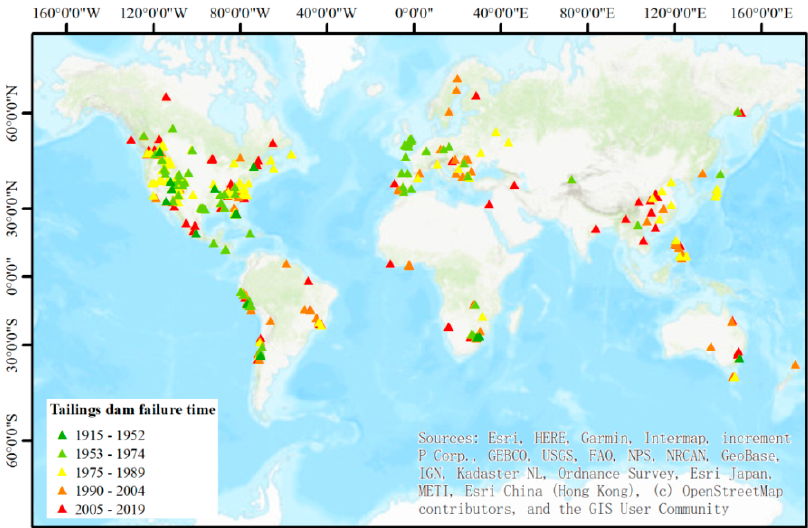
Figure 4. Tailings dam failures (1915-2019) with their occurrence